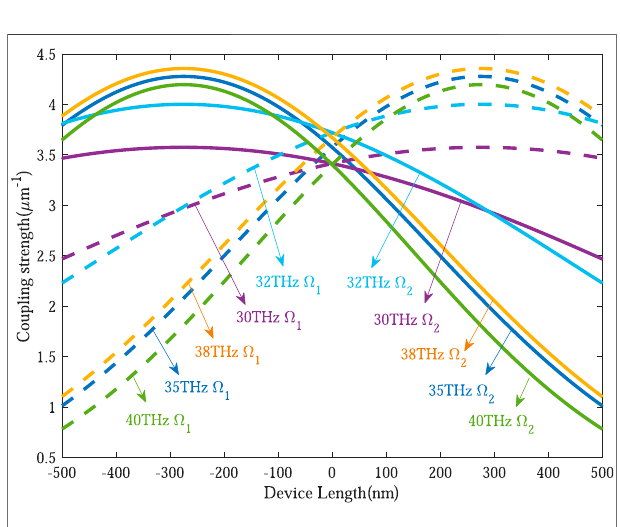
FIGURE 5 | Coupling strengths distribution of the input (output) waveguide and middle waveguide at different frequencies.